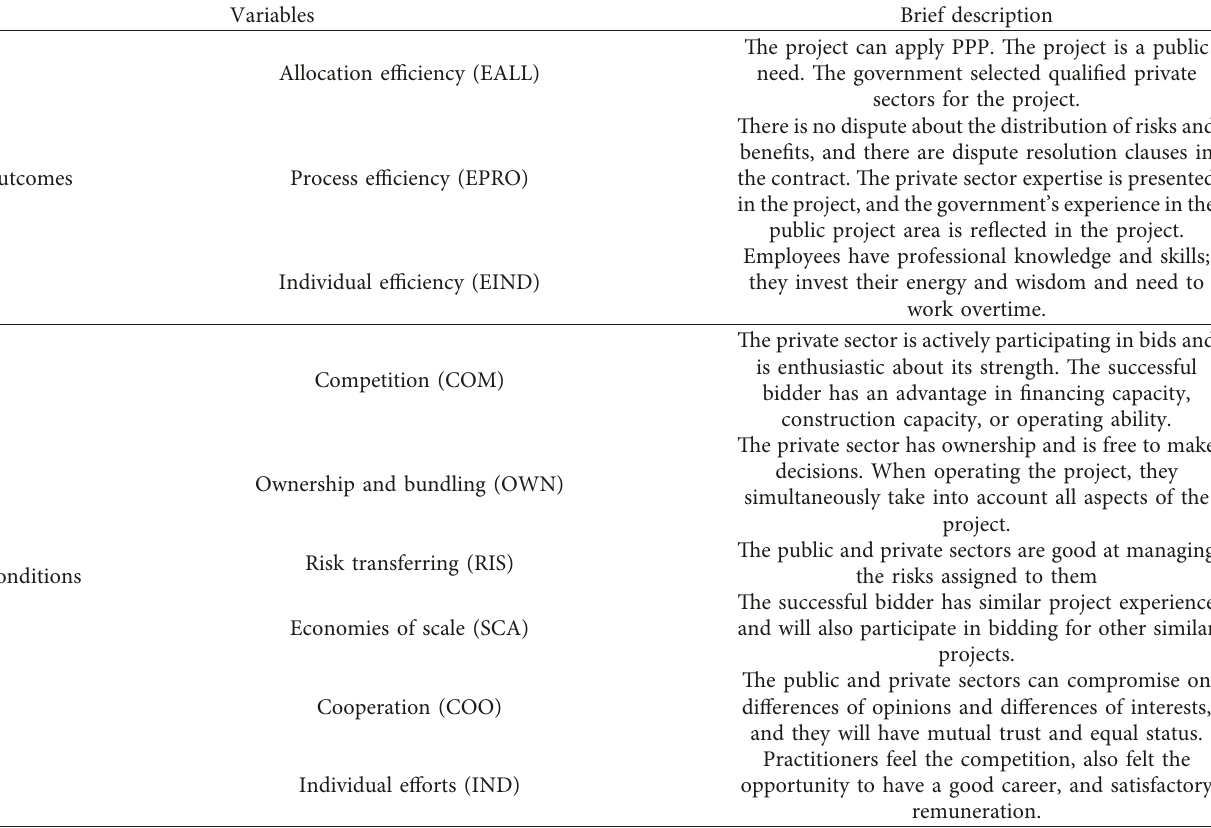
Table 3: Brief description of variables.